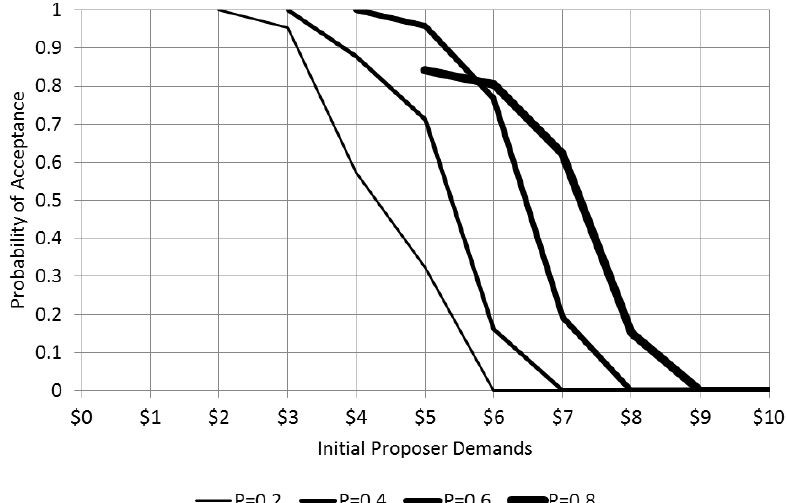
Figure 3. Responder Acceptance Probabilities as Functions of Proposer